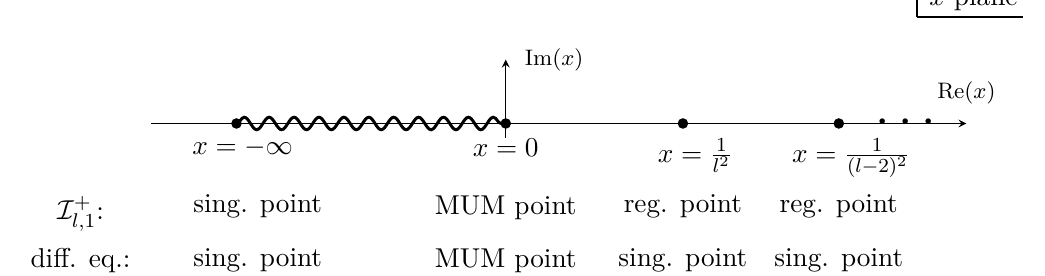
Figure 3 . Global analytic structure of the master integral I + differential operator L ice ,l . I + has a branch cut from x = 0 to x = −∞ . l, 1